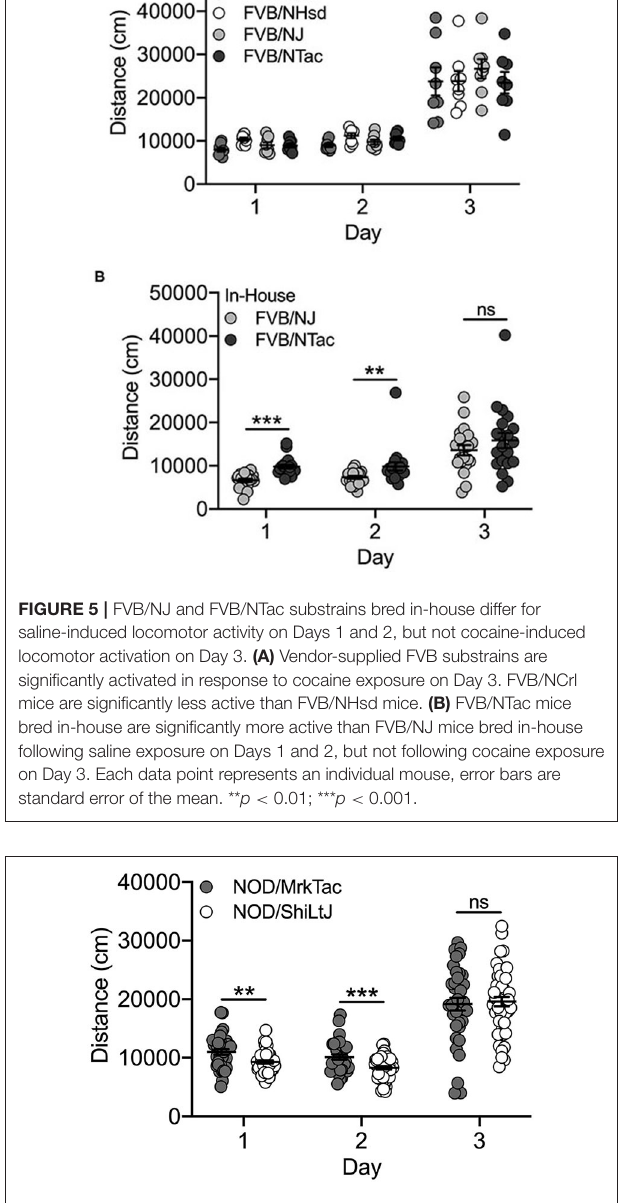
FIGURE 6 | NOD substrains bred in-house differ for locomotor activity in response to saline but not cocaine. All NOD mice, regardless of substrain, had higher locomotor activity following cocaine administration compared to saline. NOD/MrkTac mice are significantly more active than NOD/ShiLtJ mice on Days 1 and 2 following saline exposure but not in response to cocaine on Day 3. Each data point represents an individual mouse, error bars are standard error of the mean. ** p < 0.01; *** p <